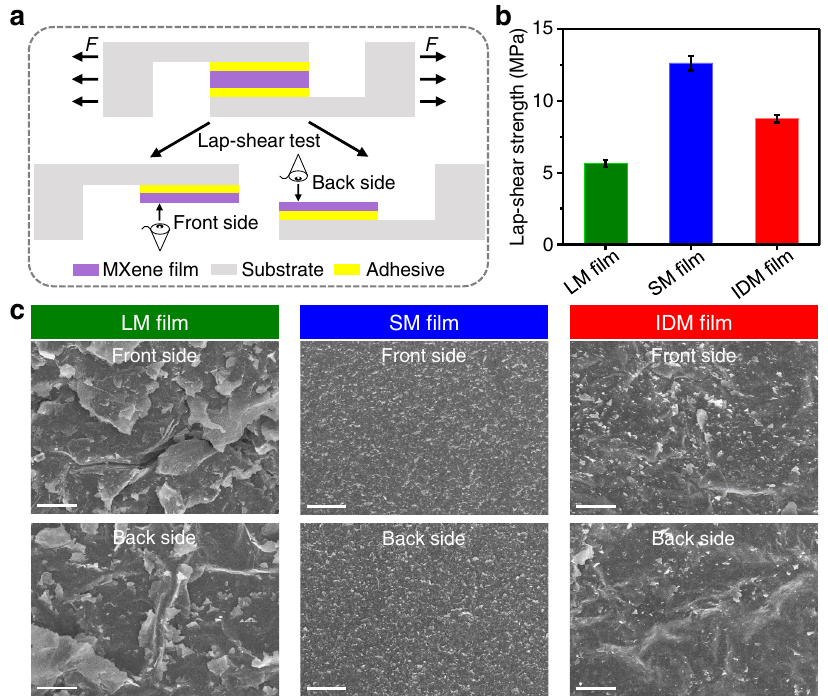
Fig. 3 | Lap-shear tests of LM, SM, and IDM fi lms. a Schematic illustration of the lap-sheartestprocess.ArectangularMXene fi lmwithalateralsizeof3×4mm 2 was gluedbetweentwoparallelglasssubstratesusinganepoxyadhesive.Ashearstress was then applied by pulling the substrates in the opposite direction at a speed of 0.2mmmin − 1 up to fi lm delamination. After delamination, two fractured surfaces